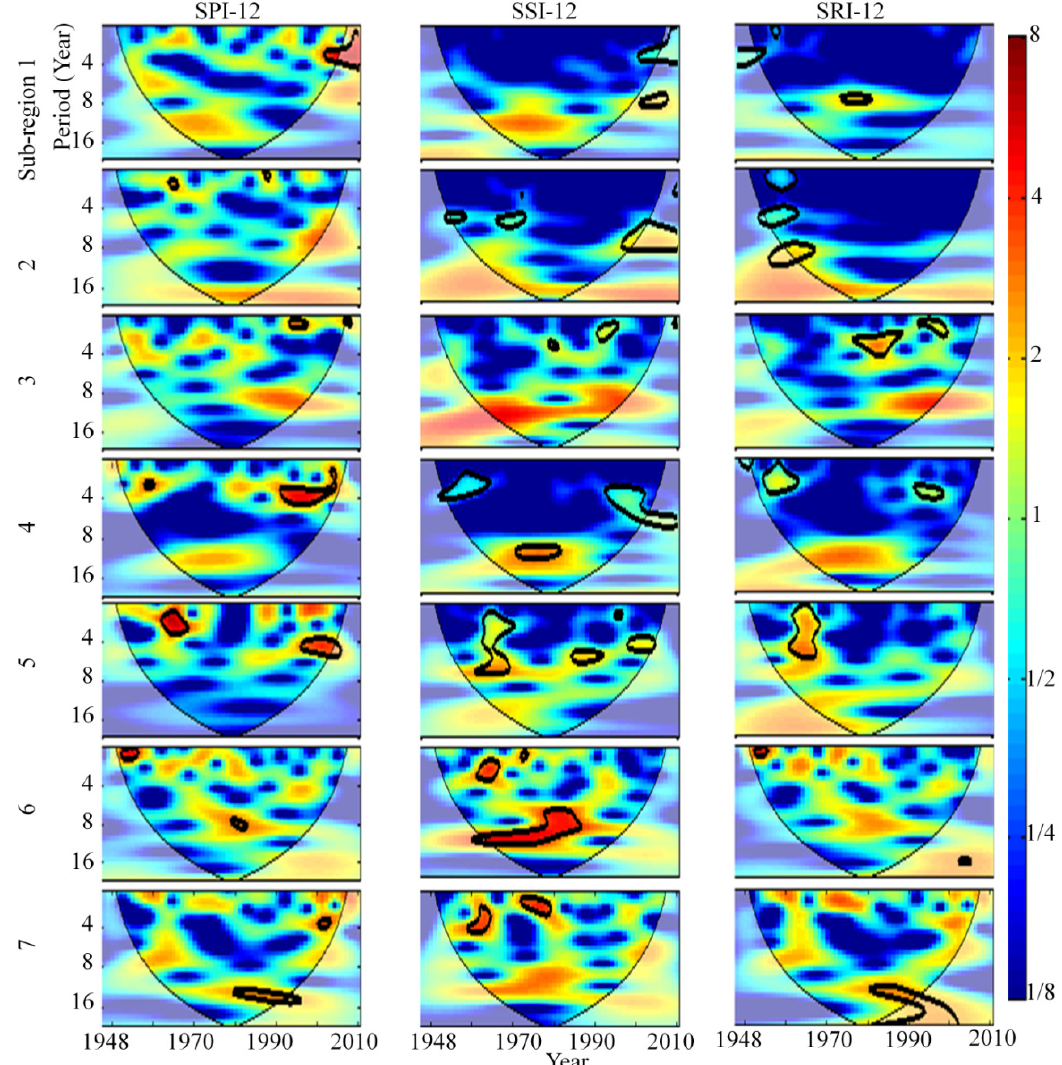
Figure 9. The wavelet spectra of the 12-month SPI, SSI, and SRI in different sub-regions of mainland China over 1948–2010. The thin solid lines denote the cones of influence, and the thick solid lines show the 95% confidence levels. The color bar means the vibration intensity of the periods at different timescales.